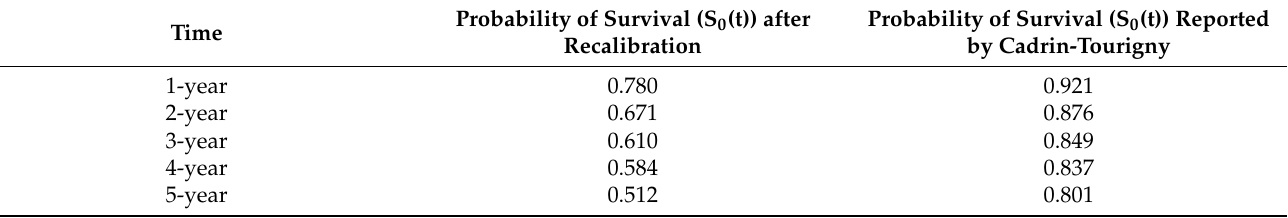
Table 3. Predicted probability of survival for different follow-up durations.